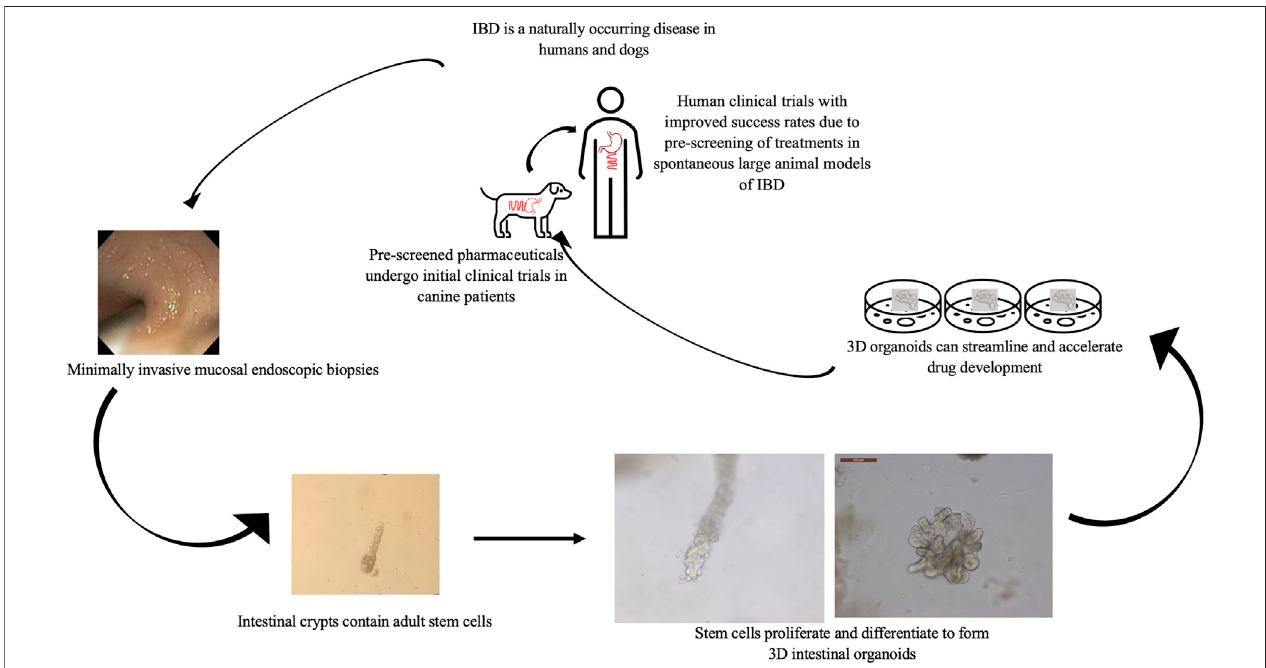
FIGURE 2 | Value of the combined in vitro – in vivo approach using 3D intestinal organoids and clinical trials in canine IBD patients to streamline drug research and development.UsingcanineswithspontaneouslyoccurringcIBDallowsforminimallyinvasiveacquisitionofendoscopicbiopsiestogenerate invitro organoidcellculture. Organoids can be used to screen candidate treatments which then can be further evaluated in live canine patients before moving forward with human clinical trials to expedite and improve research ef fi ciency.